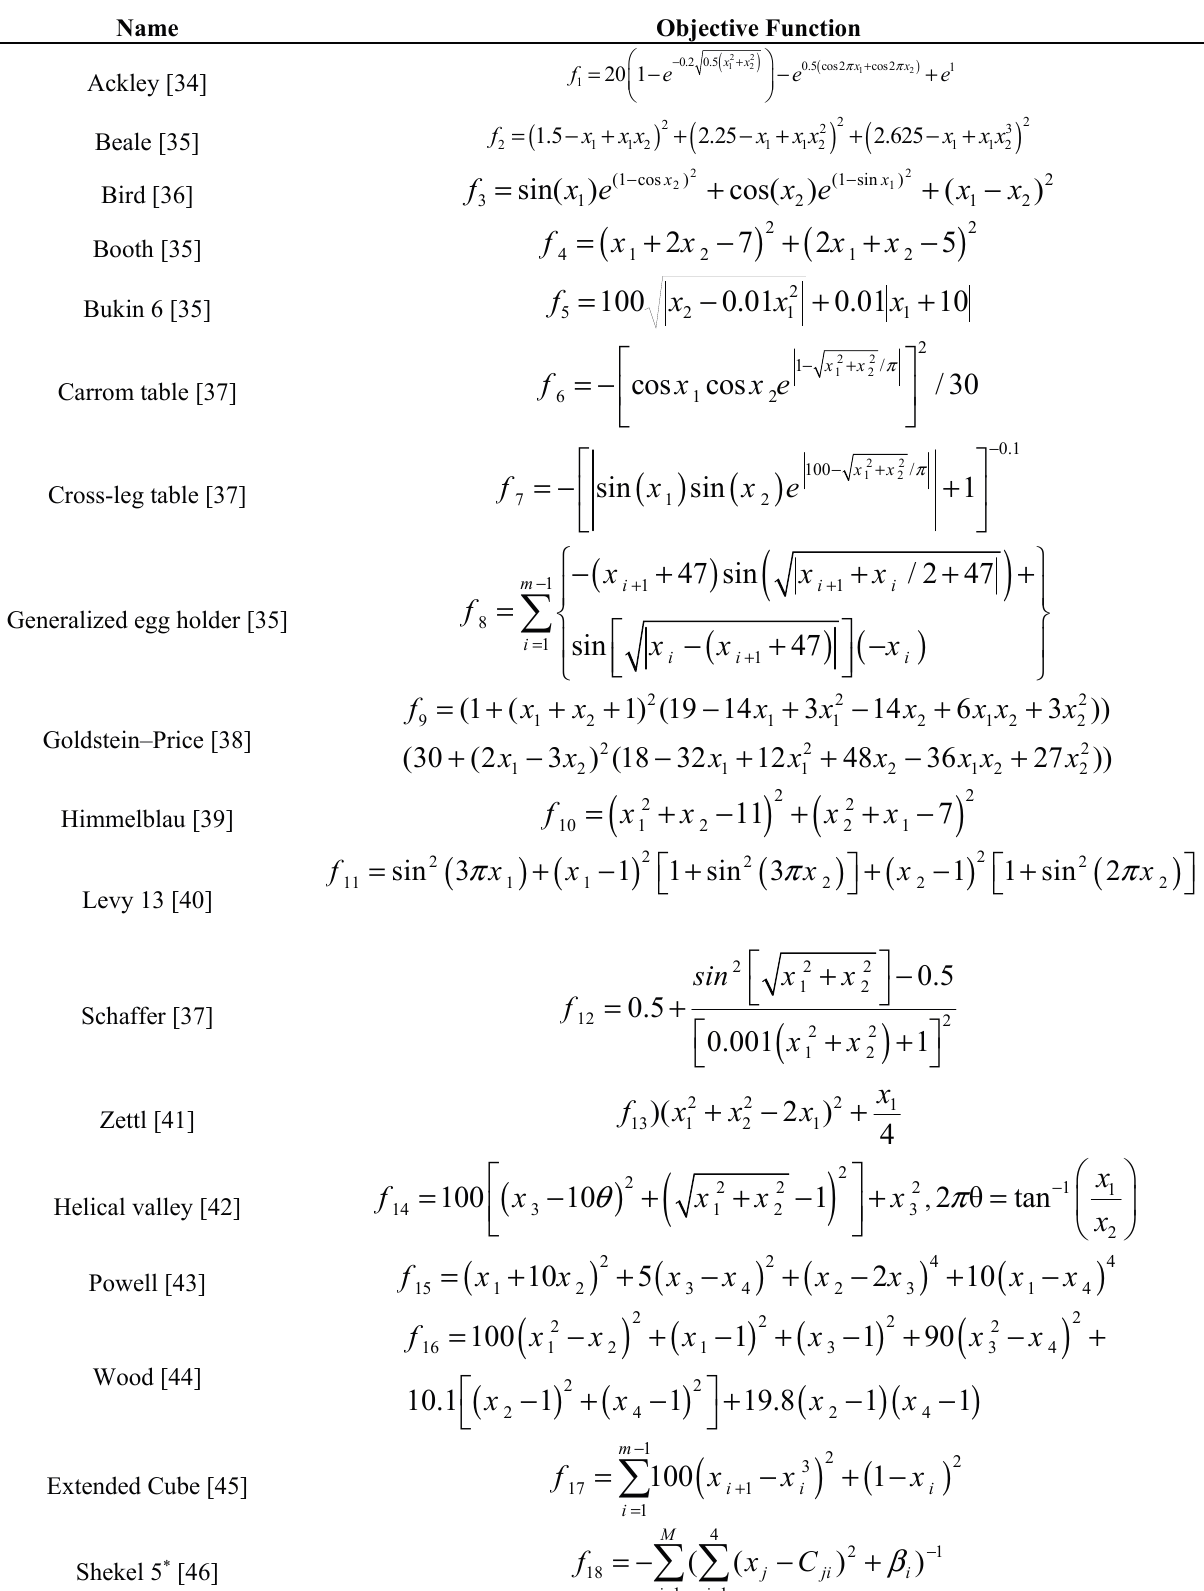
Table 1. Benchmark functions used for testing the performance of MA, KHA and